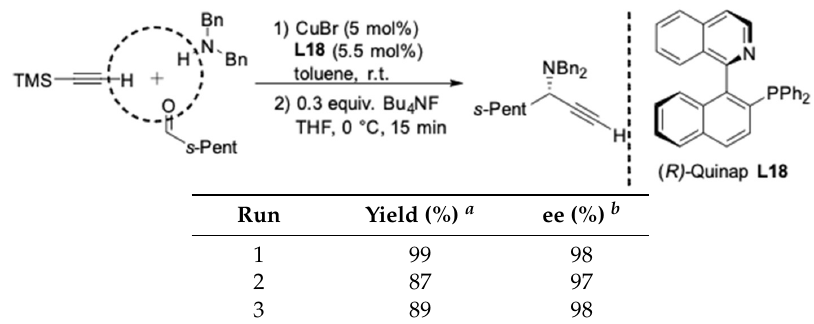
Table 2. Catalyst recycling on the AA 3 -coupling.